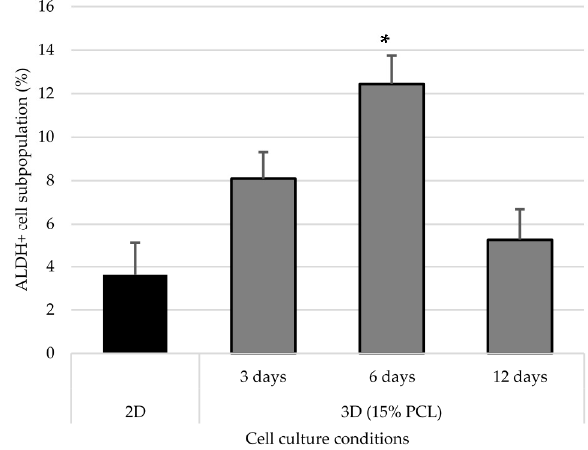
Figure 7. ALDH + cell subpopulation of MDA–MB–231 cells after monolayer culture (2D) or three-dimensional cell culture with 15% PCL scaffolds (3D). (*) Denotes significant ( p < 0.05) differences between 3D culture at a given time point and 2D.